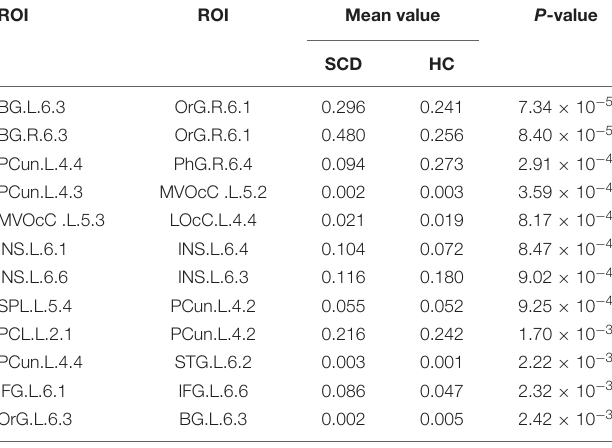
TABLE 6 | Consensus connections identified by structural brain network based on DTI.